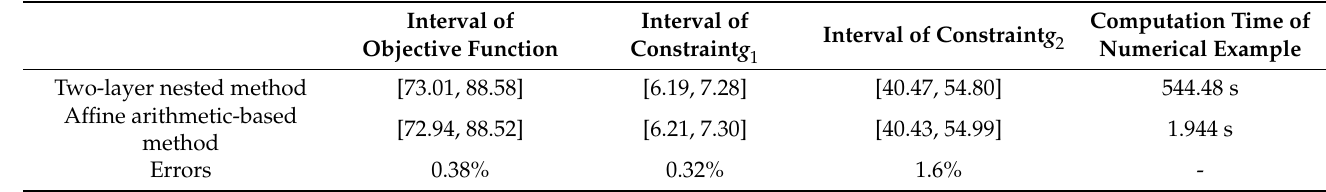
Table 5. Comparison of optimization